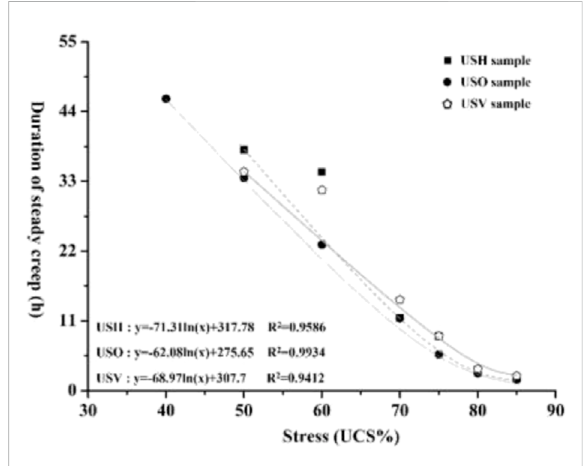
FIGURE 8 Strain-time curve of USV group samples.